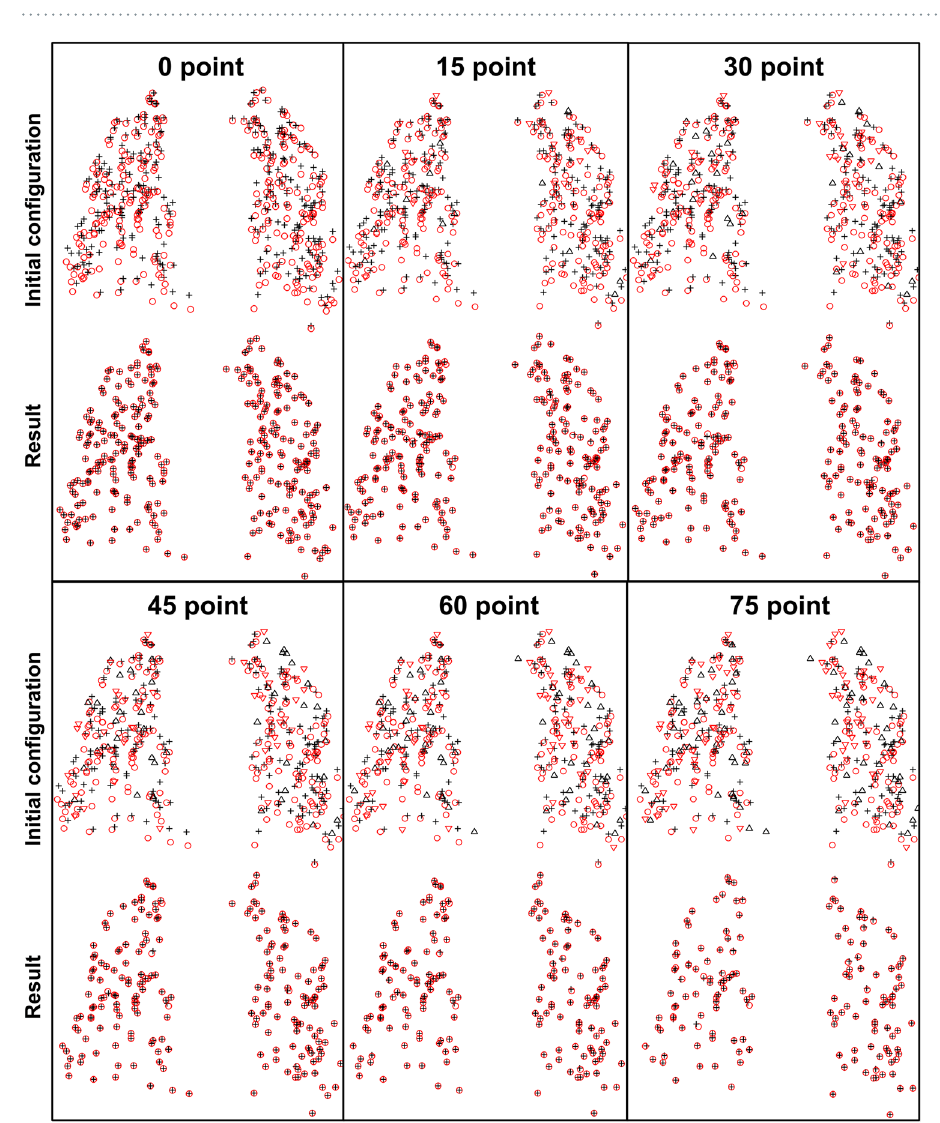
Figure 11. Performance of DSMM on the incomplete 3D lung data pairs identified from 4D CT images. We randomly remove increasing number of points both in the target point set and the template point set, which breaks up the one-to-one correspondence between the given data. For clarity, the red “ ∇ ” denote the missing correspondences, whose correspondences are removed in the template set, and the black “ ∆ ” denotes the missing correspondences in the template set. Our method shows its stable performance on the missing correspondences and occlusion. The top image in the each subfigure shows the initial configuration of incomplete data, and the bottom ones show the result of our